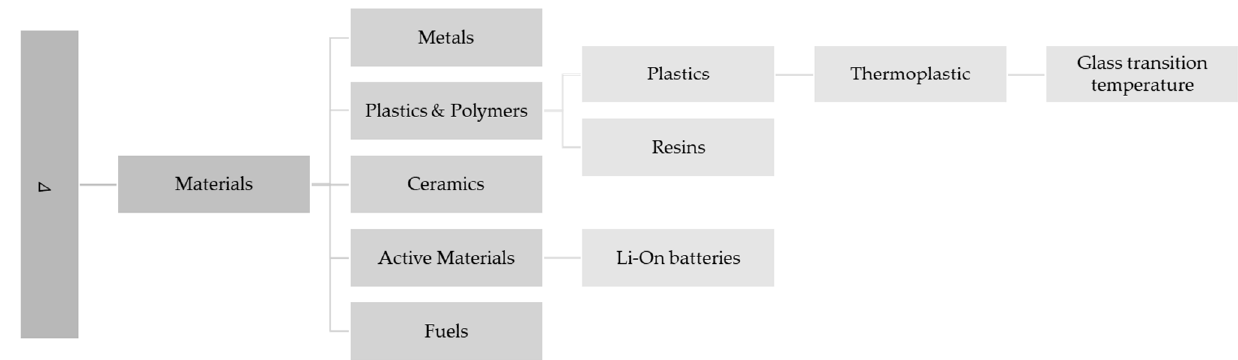
Figure A10. Technologies’ classification: Materials-related branch.